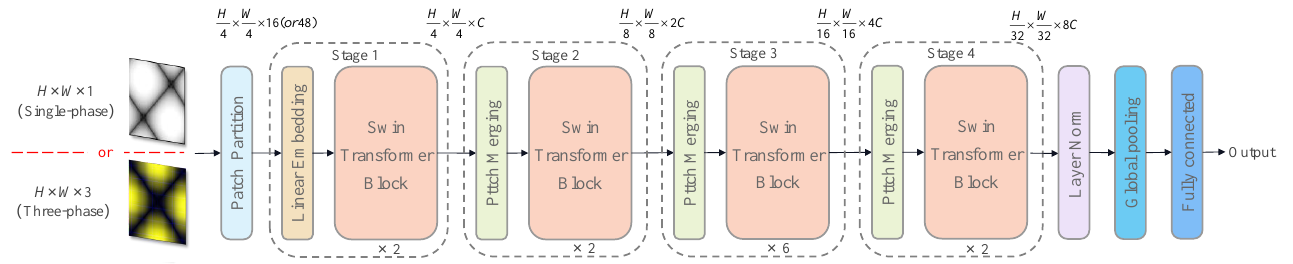
Figure 8. Main structure of Swin-T network for load